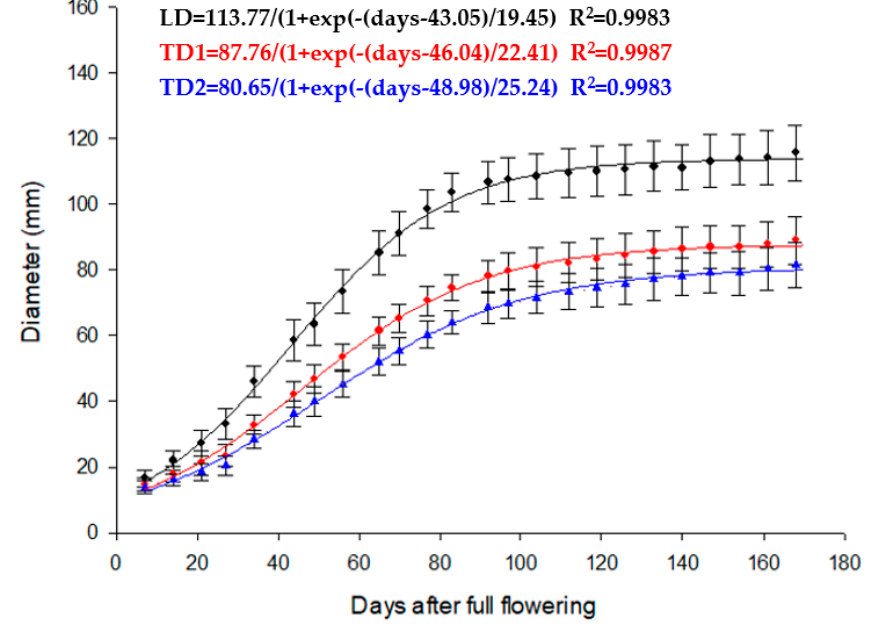
Figure 1. Time course of the diameters of the selected fruits (LD—Longitudinal Diameter—in black, TD1—Major Transversal Diameter—in red, TD2—Minor Transverse Diameter—in